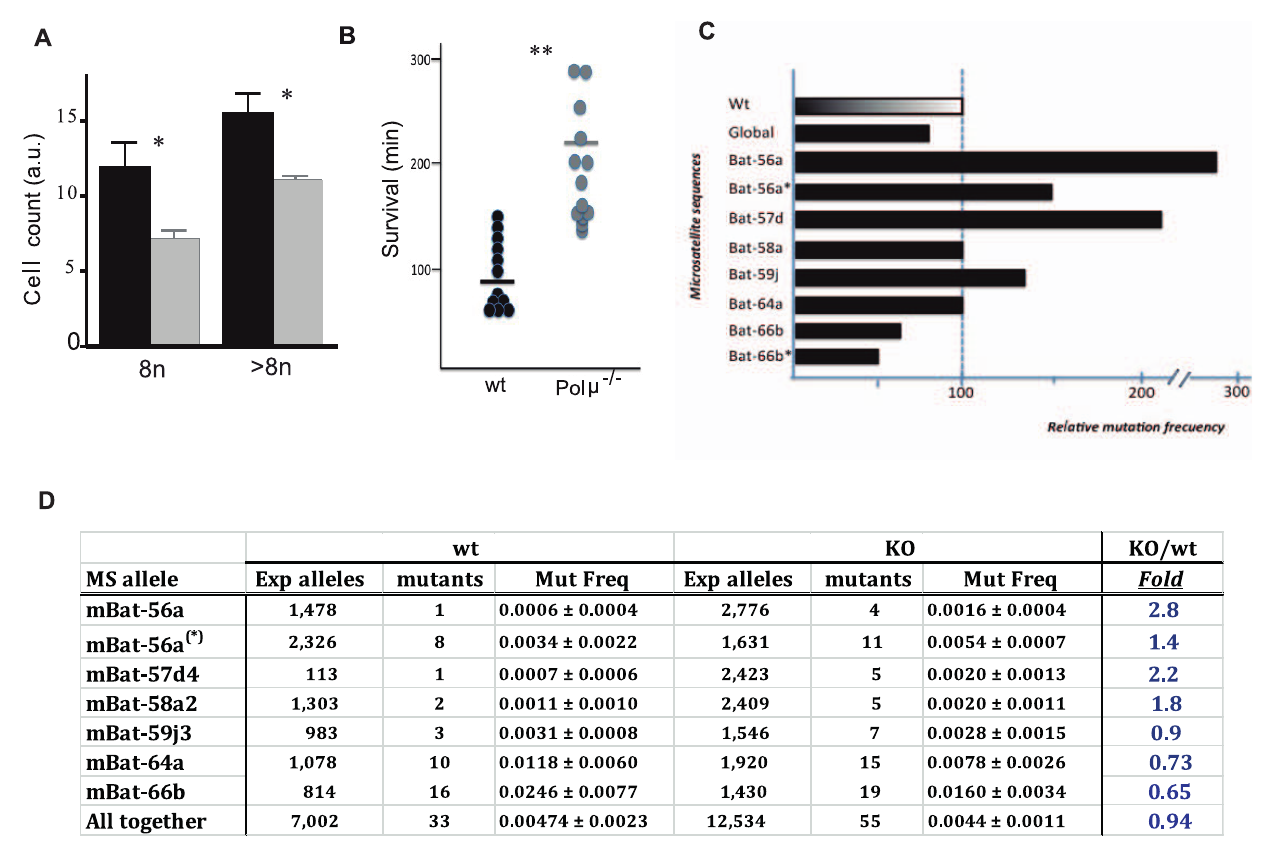
Figure 4. Genetic stability in Pol m 2 / 2 mice. ( A ) Polyploidy (determined by PI staining) in hepatocytes from old (14 m) wt (black) and Pol m 2 / 2 mice (gray). Data are presented as the relative amounts (arbitrary units) of 8n and $ 8n cells (means 6 SEM, 4 samples per genotype. ( B ) Survival (min) of adult (8–12 w) mice after i.v. injection with paraquat (70 mg/kg). Individual data and means are shown for wt (black) and Pol m 2 / 2 (gray) mice (n=13). Data are means 6 SEM. ( C, D ) Comparative mutation frequency (MF) in a panel of selected microsatellites (MS) in Pol m 2 / 2 mice vs wt animals. The table ( D ) compares individual absolute MF values in the different MS sequences analyzed in Pol m 2 / 2 mice relative to wt animals (100%); (*) indicates animals treated with paraquat.